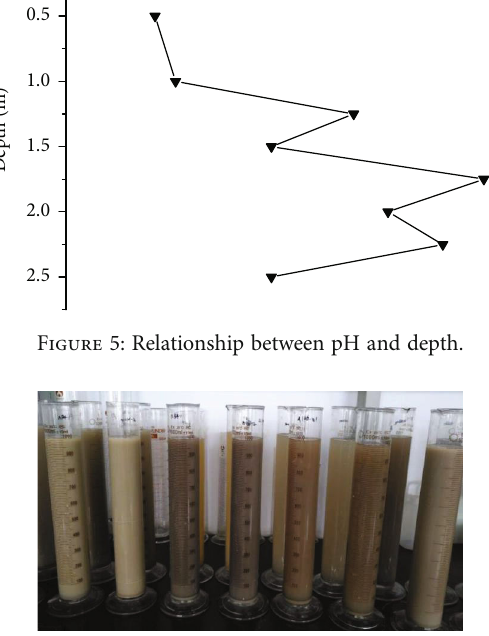
Figure 6: Preparation of the soil-water